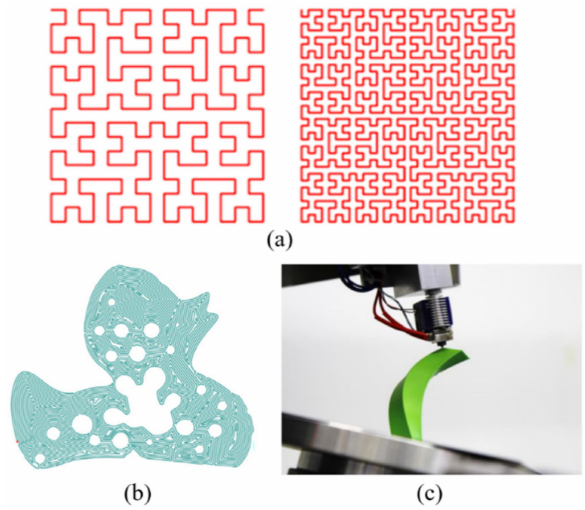
Figure 6. ( a ) Hilbert curves path pattern reproduced with permission from [62]. Elsevier, 2018; ( b ) an example of generated paths for porous structures reproduced with permission from [65]. Elsevier, 2019; ( c ) a successful fabrication by using the path planning strategy reproduced with permission from [67]. Elsevier,